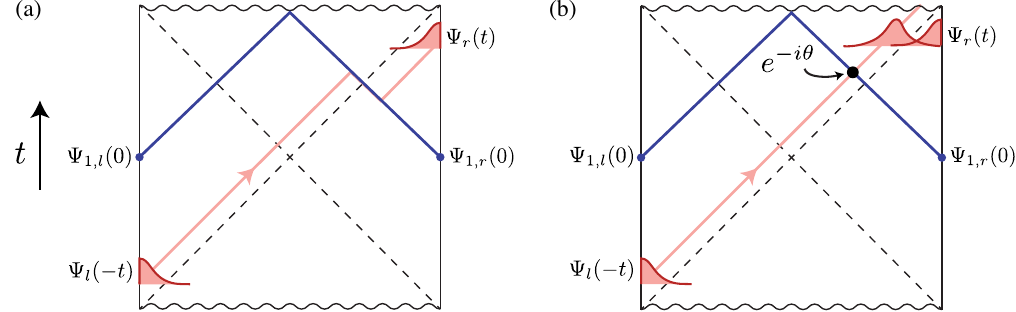
FIG. 5. Schematic of the teleportation protocol from the bulk gravitational perspective in AdS 2 , under both (a) semiclassical gravity and (b) strong stringy corrections. The TFD state corresponds to a two-sided black hole. Local quantum mechanical operators ψ create l=r (red). The protocol begins by inserting a particle on the left or annihilate particles near the two boundaries, with wave functions Ψ l=r side, with wave function Ψ (red, bottom left), at time − t , which then falls toward the interior of the geometry during time evolution (red P l ψ ψ line). The two-sided coupling ð g=N Þ is then applied, producing a shock wave (blue) that interacts with the in-falling particle i;l i;r i [7,8]. (a) In the semiclassical limit, the shock wave shifts the position of the in-falling particle outside of the right horizon (dashed), which enables the particle to reemerge near the right boundary (red, top right) [7,8]. (b) When stringy effects are present, the scattering amplitude between the in-falling particle and the shock wave is modified according to Eq. (99) [7,32]. In the highly stringy limit and at A ε ð Δ = 2 Þ ε e ε t [Eq. (101)]. The overlap between the in-falling particle early times, the interaction results in an overall phase shift θ ¼ gG N and a particle at the right boundary is nevertheless nonzero (red, top right) and is given by the unperturbed two-point function ψ G β ¼ i< ψ > . [Note that stringy effects may also modify the initial wave functions of Ψ , as we discuss in the context of Eq. l r l=r